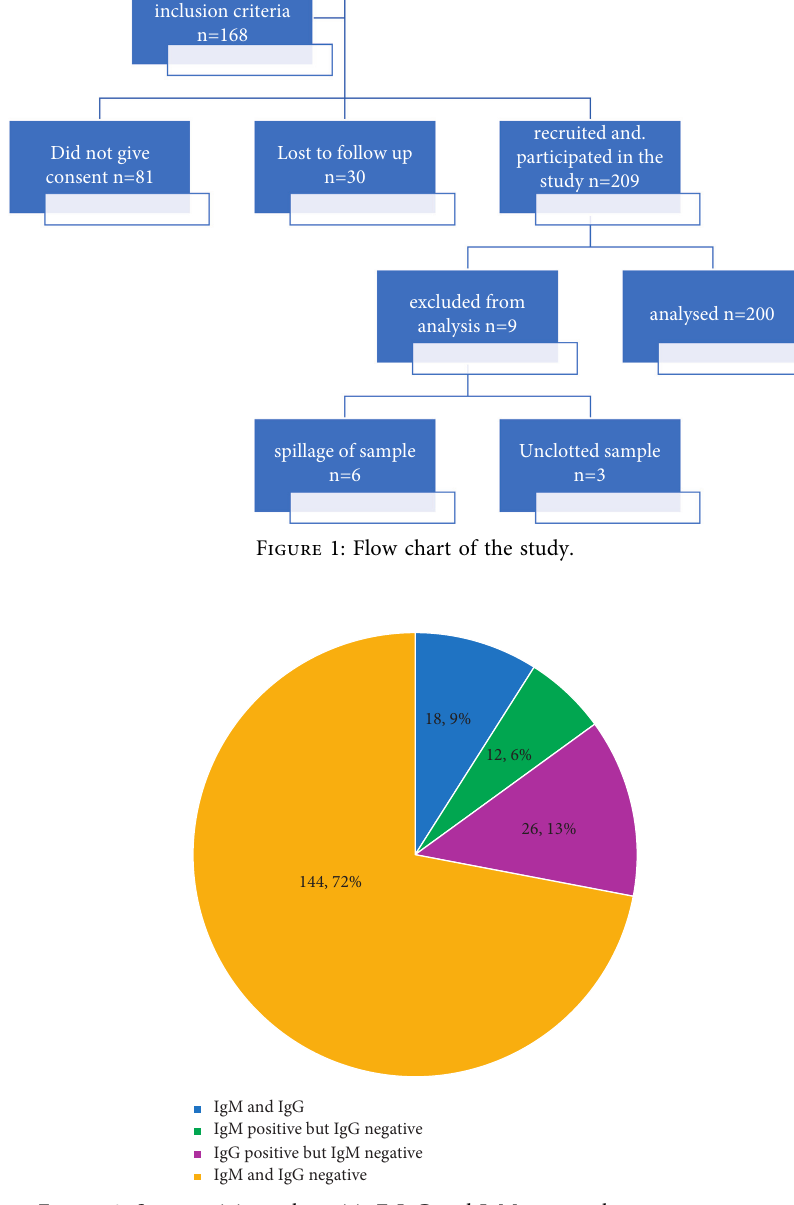
Figure 2: Seroreactivity to hepatitis E IgG and IgM among the pregnant